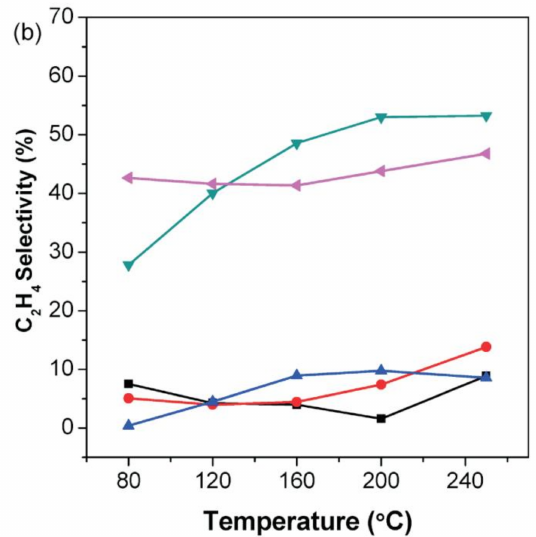
Figure 27. Reaction rate and ethylene selectivity over the SBA-15 supported Cu ( a ), Cu 10 Au 1 ( b ), Cu 3 Au 1 (c), Cu 1 Au 3 (d), and Au (e) catalysts. C 2 H 2 /H 2 /He = 1.5/15/83.5, GHSV = 40,000 mL g − 1 cat h − 1